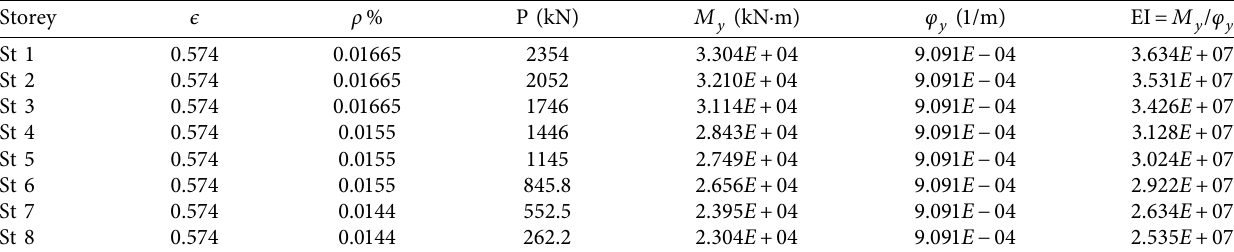
Figure 10: Roof displacement from UMRHA (mode 1 using PIVOT hysteretic model) and NRHA of the main structure. Table 5: Calculating stifness proportional to strength of 20cm wall.